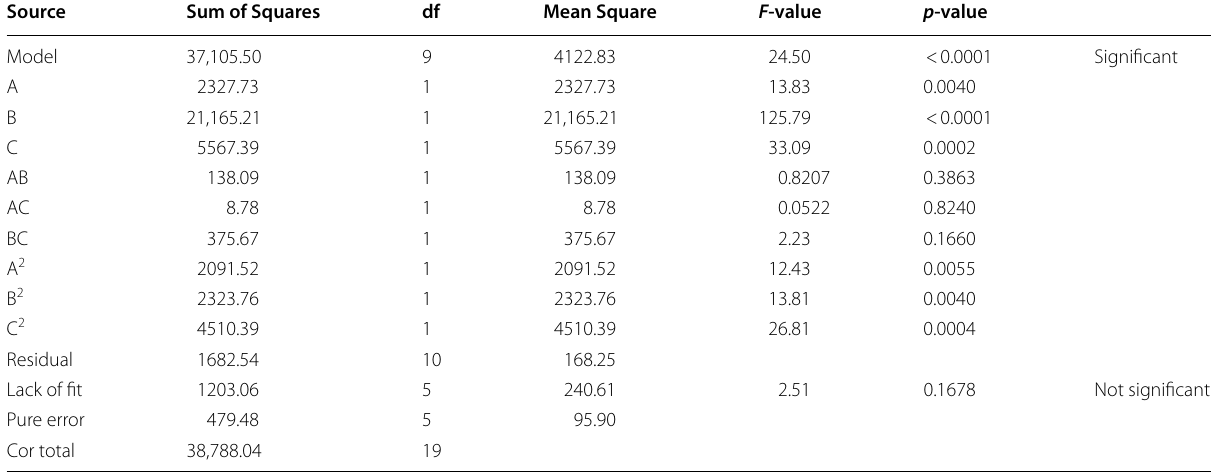
Table 2 Results of CCD ANOVA analysis